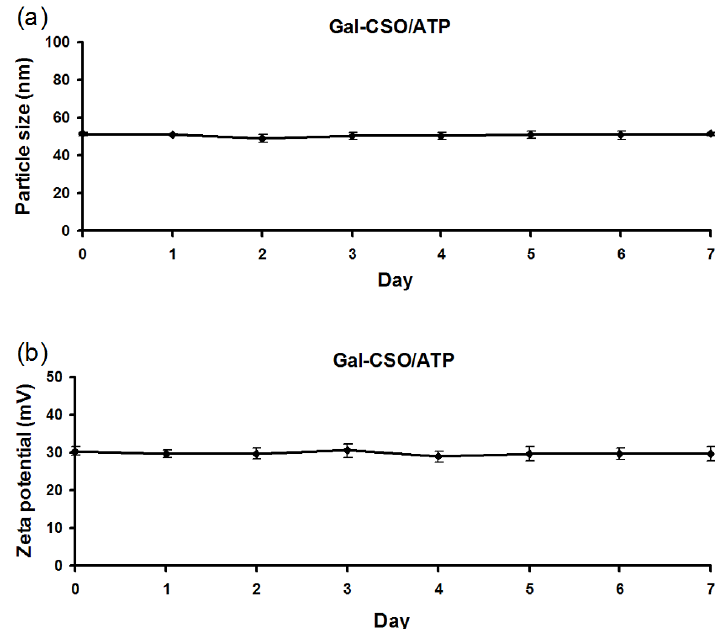
Figure 3. Stability of Gal-CSO/ATP nanoparticles. ( a ) The average particle size and ( b ) zeta potential of Gal-CSO/ATP remained stable for up to seven days after synthesis. Data represent the mean ± standard deviation ( n =